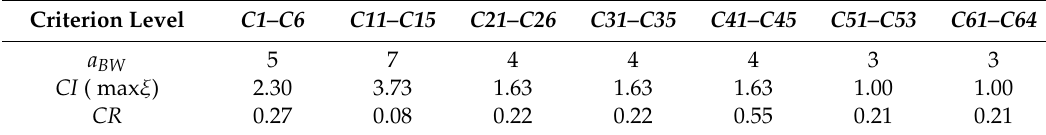
Table 5. The consistency index and the consistency ratio of our modified Best Worst Method (BWM-I). Criterion